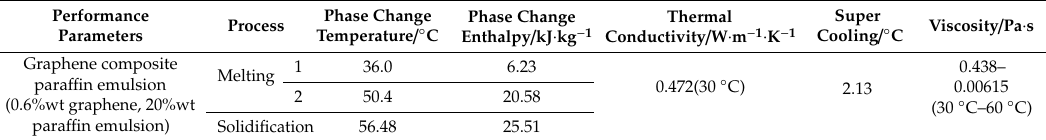
Table 1. Performance parameters of graphene composite para ffi n